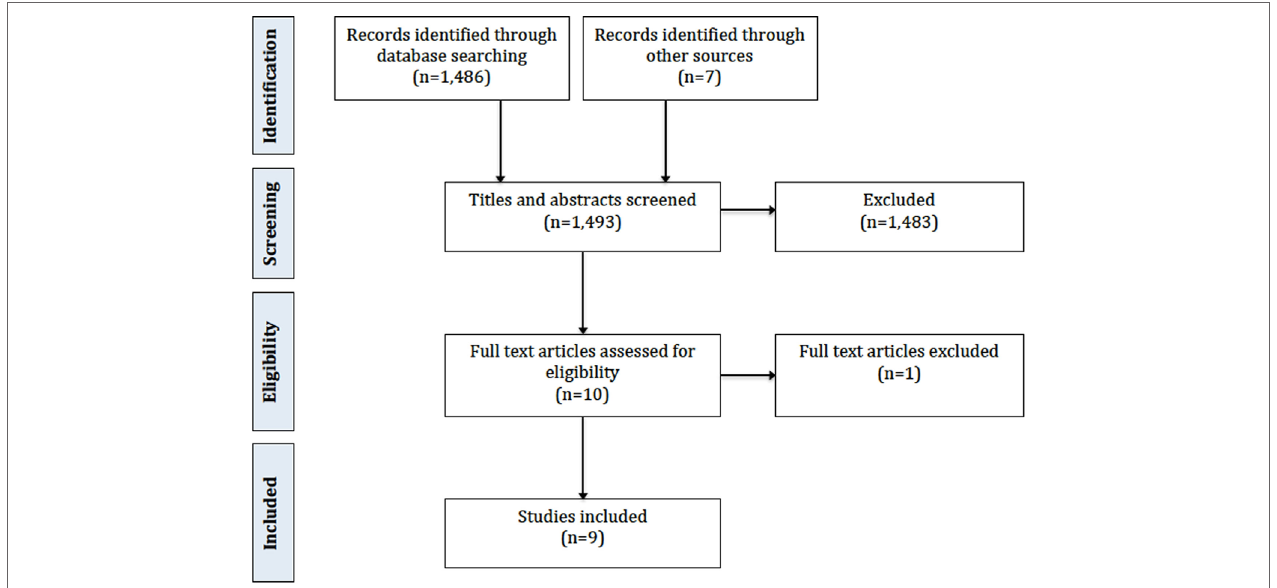
FigURe 1 | Preferred Reporting Items for Systematic Reviews and Meta-Analyses 2009 flow